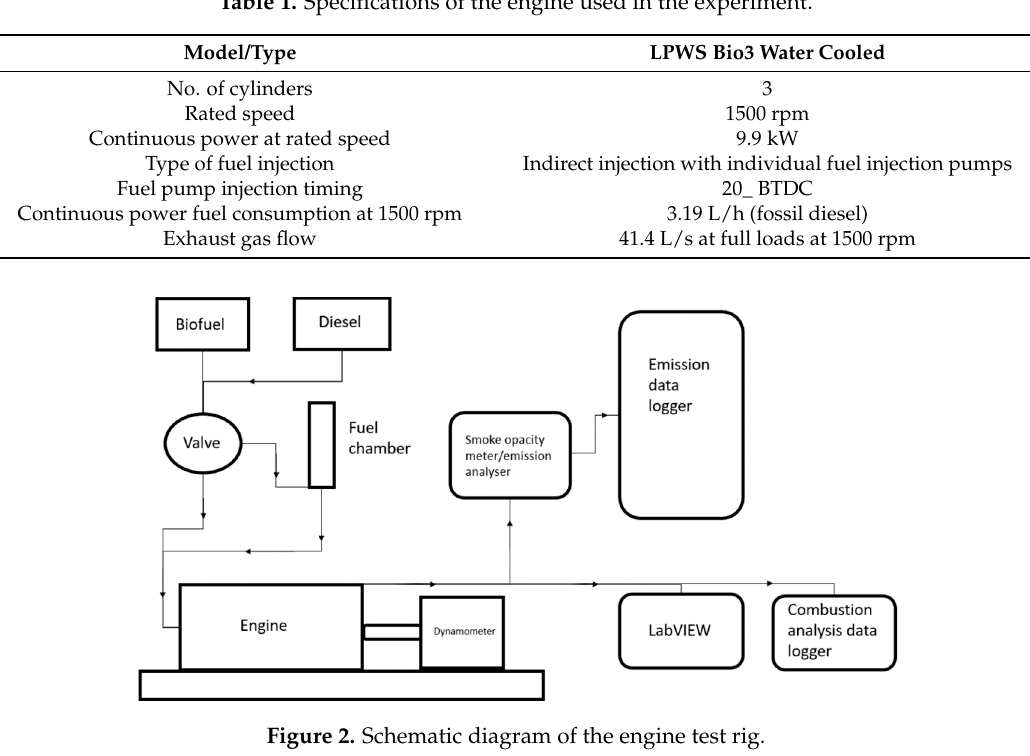
Table 2. Measured properties of the test fuels.